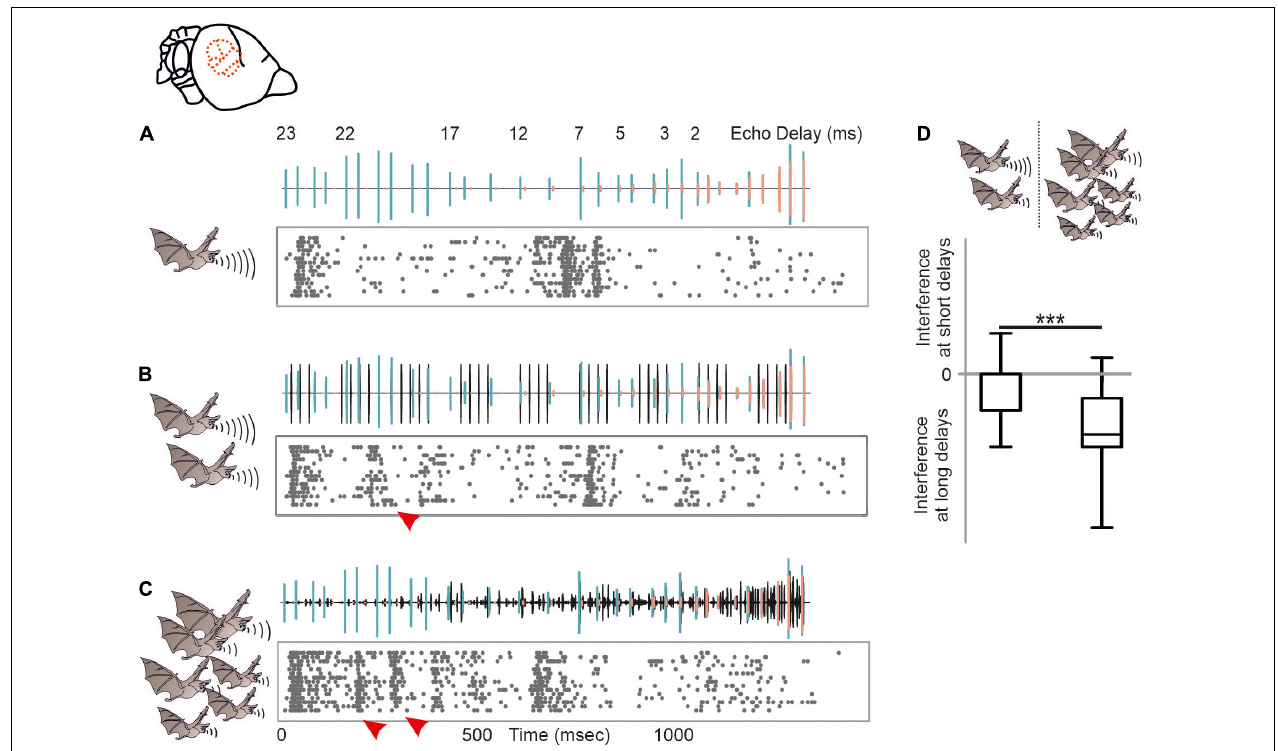
FIGURE 7 | Acoustic interference arising from different naturalistic masker in the auditory cortex of C. perspicillata . (A–C) Neural activity of a cortical unit in response to the target sequence alone (A) , target sequence embedded in a moderate interferer (scenario when two bats echolocate) (B) , and target sequence embedded in strong interferer (scenario encountered in a bat colony) (C) . Oscillograms of the stimuli are shown above each raster plot. Respectively, call and echoes of the target stimulus are indicated in green and orange, while the interferer is shown in black. (D) Acoustic interference, shown as additional spikes in ( red arrowheads in B , C ) that were absent in (A) , preliminary occurs at the beginning of the sequence where long delays of the target sequence were dominant (Kruskal–Wallis test and Dunn’s multiple comparison post hoc test: ∗∗∗ p < 10 - 5 ). Data from Beetz et al.